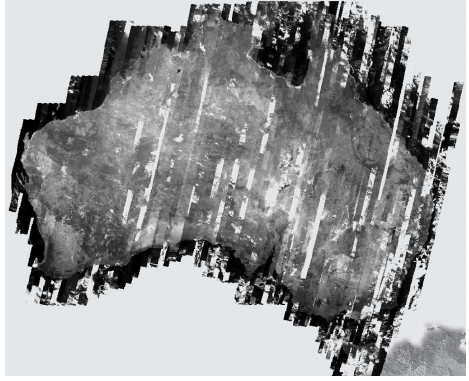
Figure 1. AGRI national mosaic of ALOS PRISM imagery.